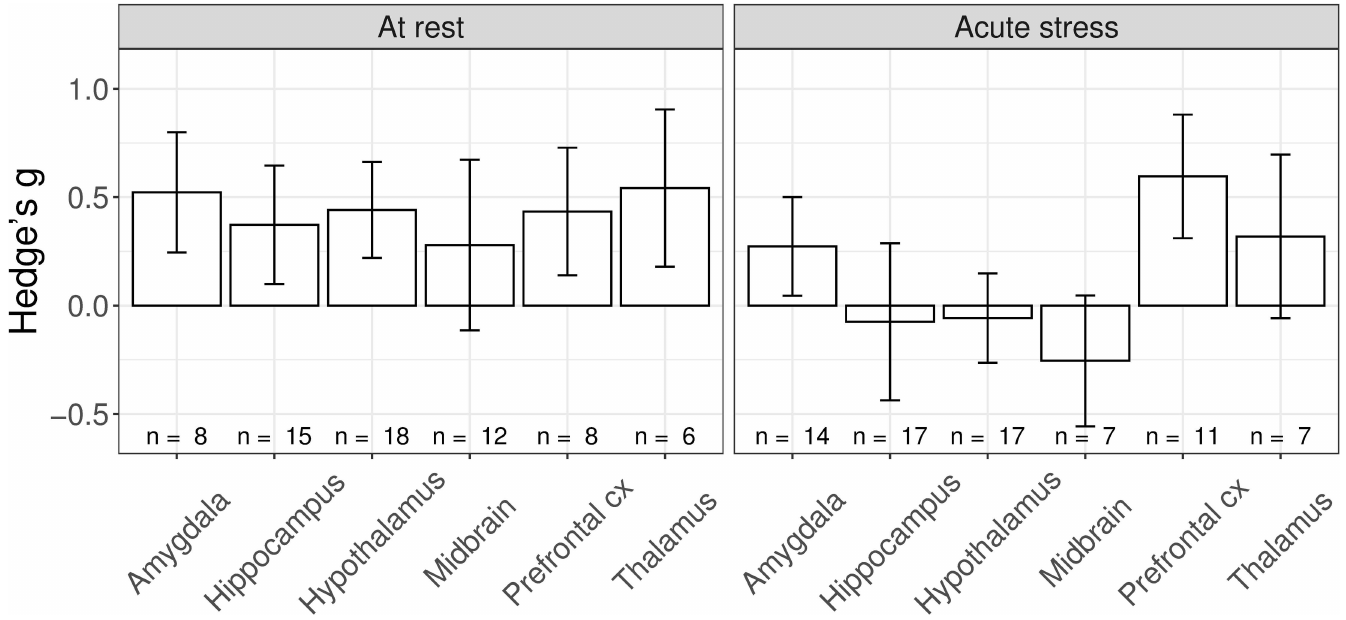
Fig 5. Effects of ELA on cFos expression across brain areas at rest and after an acute stressor.